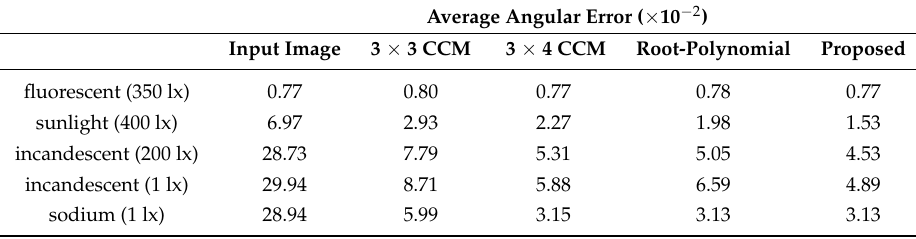
Table 3. Average angular